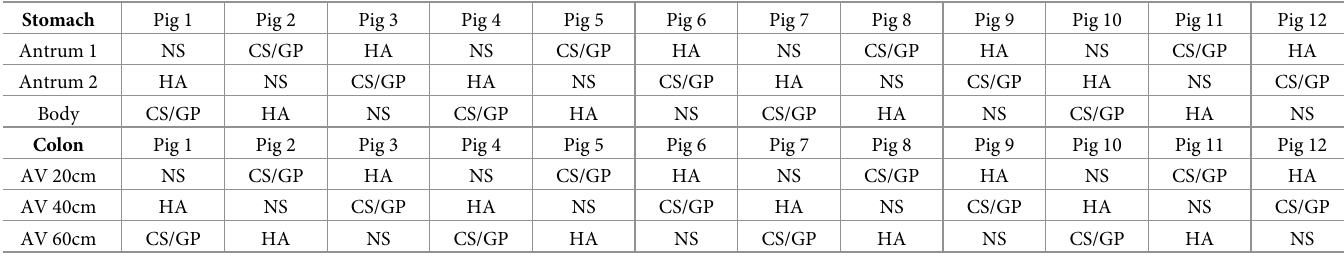
Table 1. Random allocation of submucosal fluids according to location.